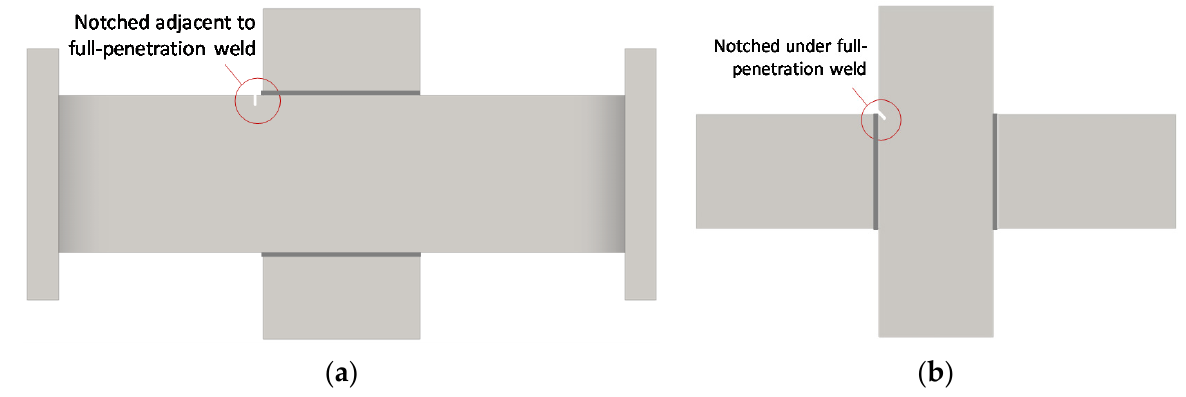
Figure 23. Notch location for ( a ) full-scale specimen and ( b ) half-scale specimen.